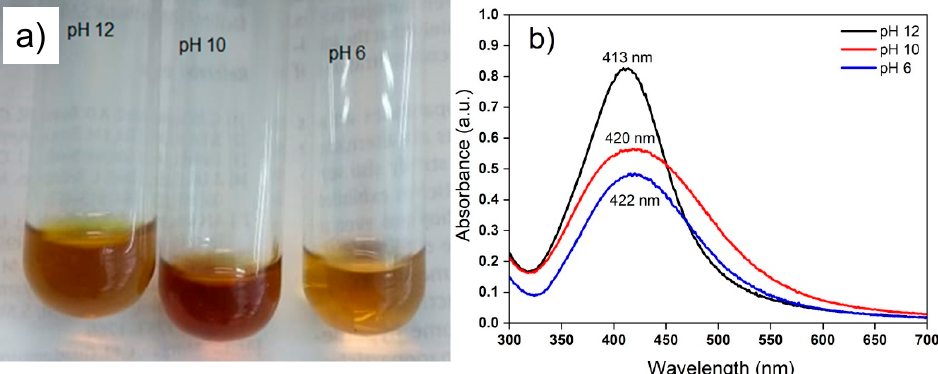
Figure 3. Effect of the extract pH on the formation of AgNPs monitored by UV–vis at 24 h. ( a ) Typical coloration of AgNPs synthesized and ( b ) absorption spectra at different pH.